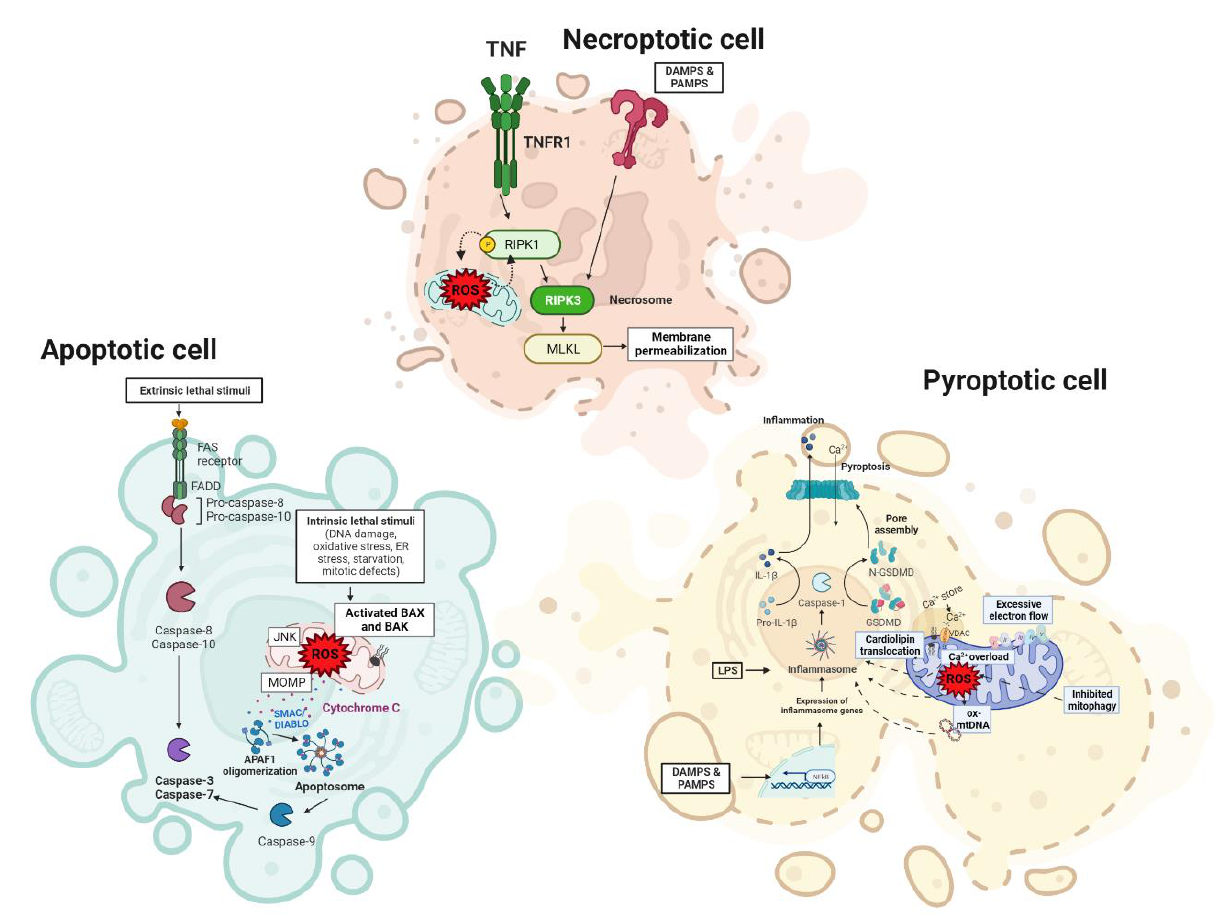
Figure 3. Scheme of the pathways associated with apoptosis, necrosis and pyroptosis cell